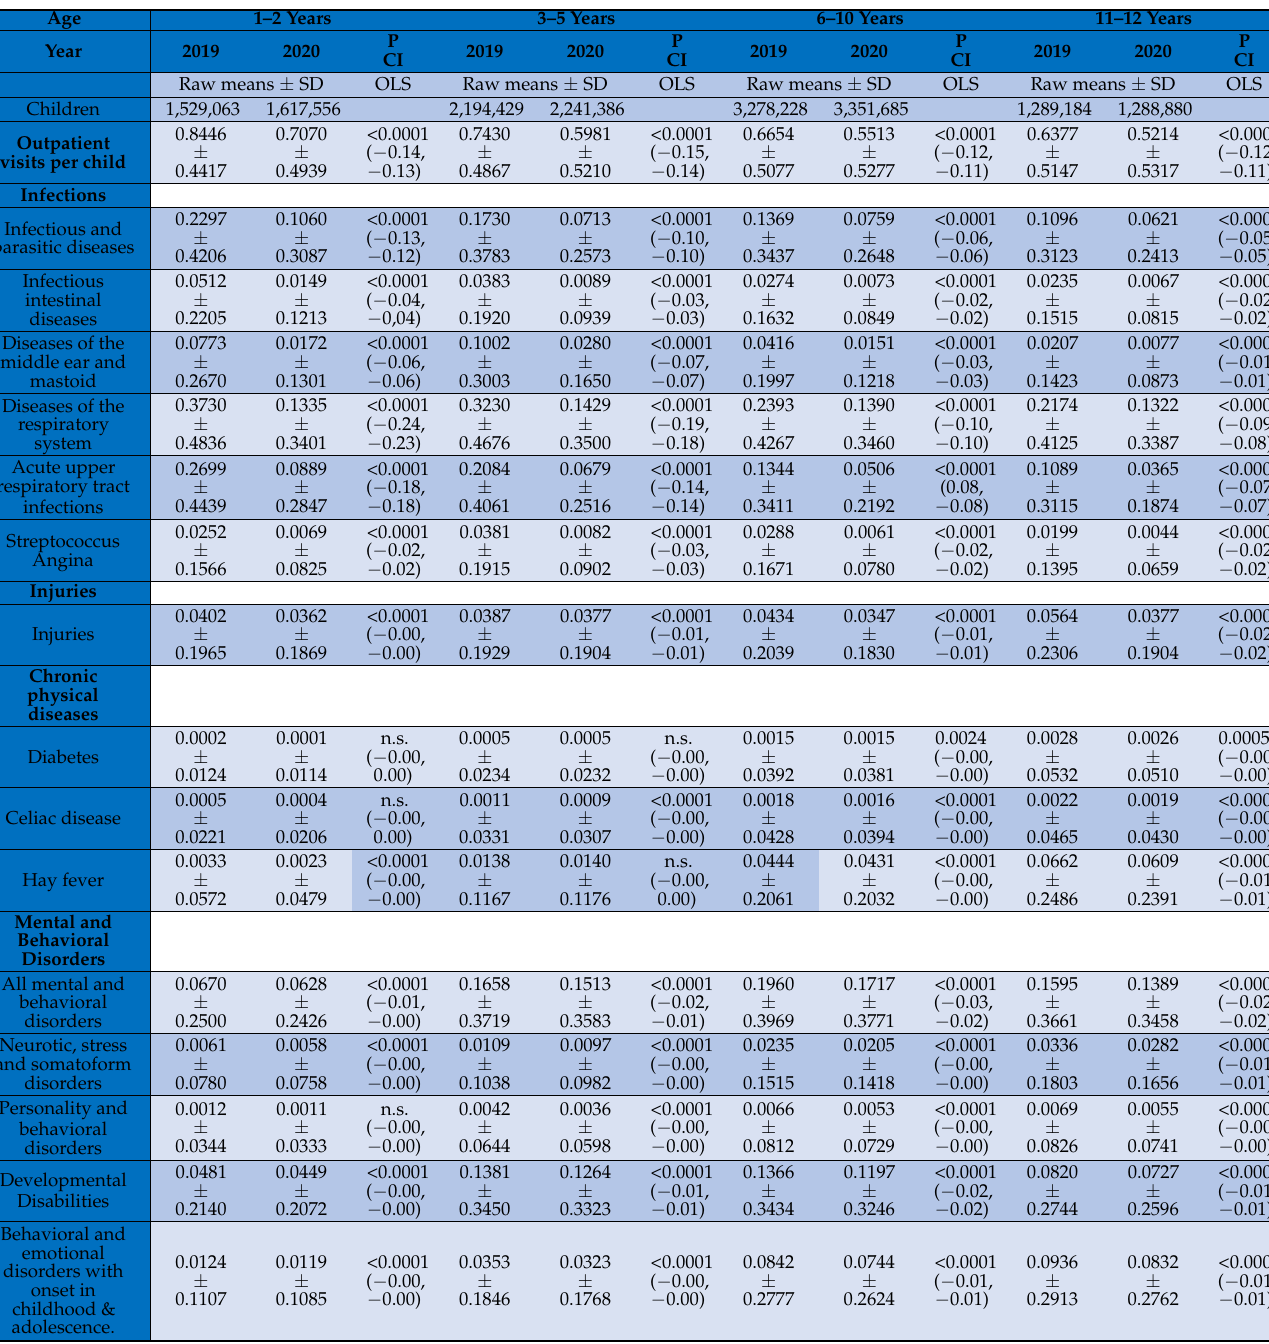
Table 1. Number of outpatient doctor’s visits per child and frequency of selected diagnoses (ICD 10 codes) during Q2 2019 (control) and Q2 2020 (pandemic) for all children in Germany with statutory health insurance who presented to a physician’s office between January 2019 and June 2020, categorized by age group. SD = standard deviation, CI = confidence intervals, OLS = binary Ordinary Least Square